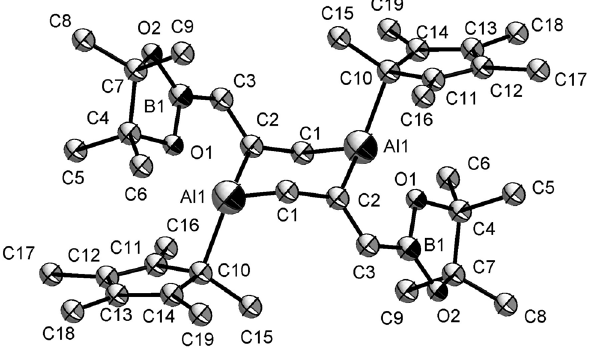
Table  : Data collection and